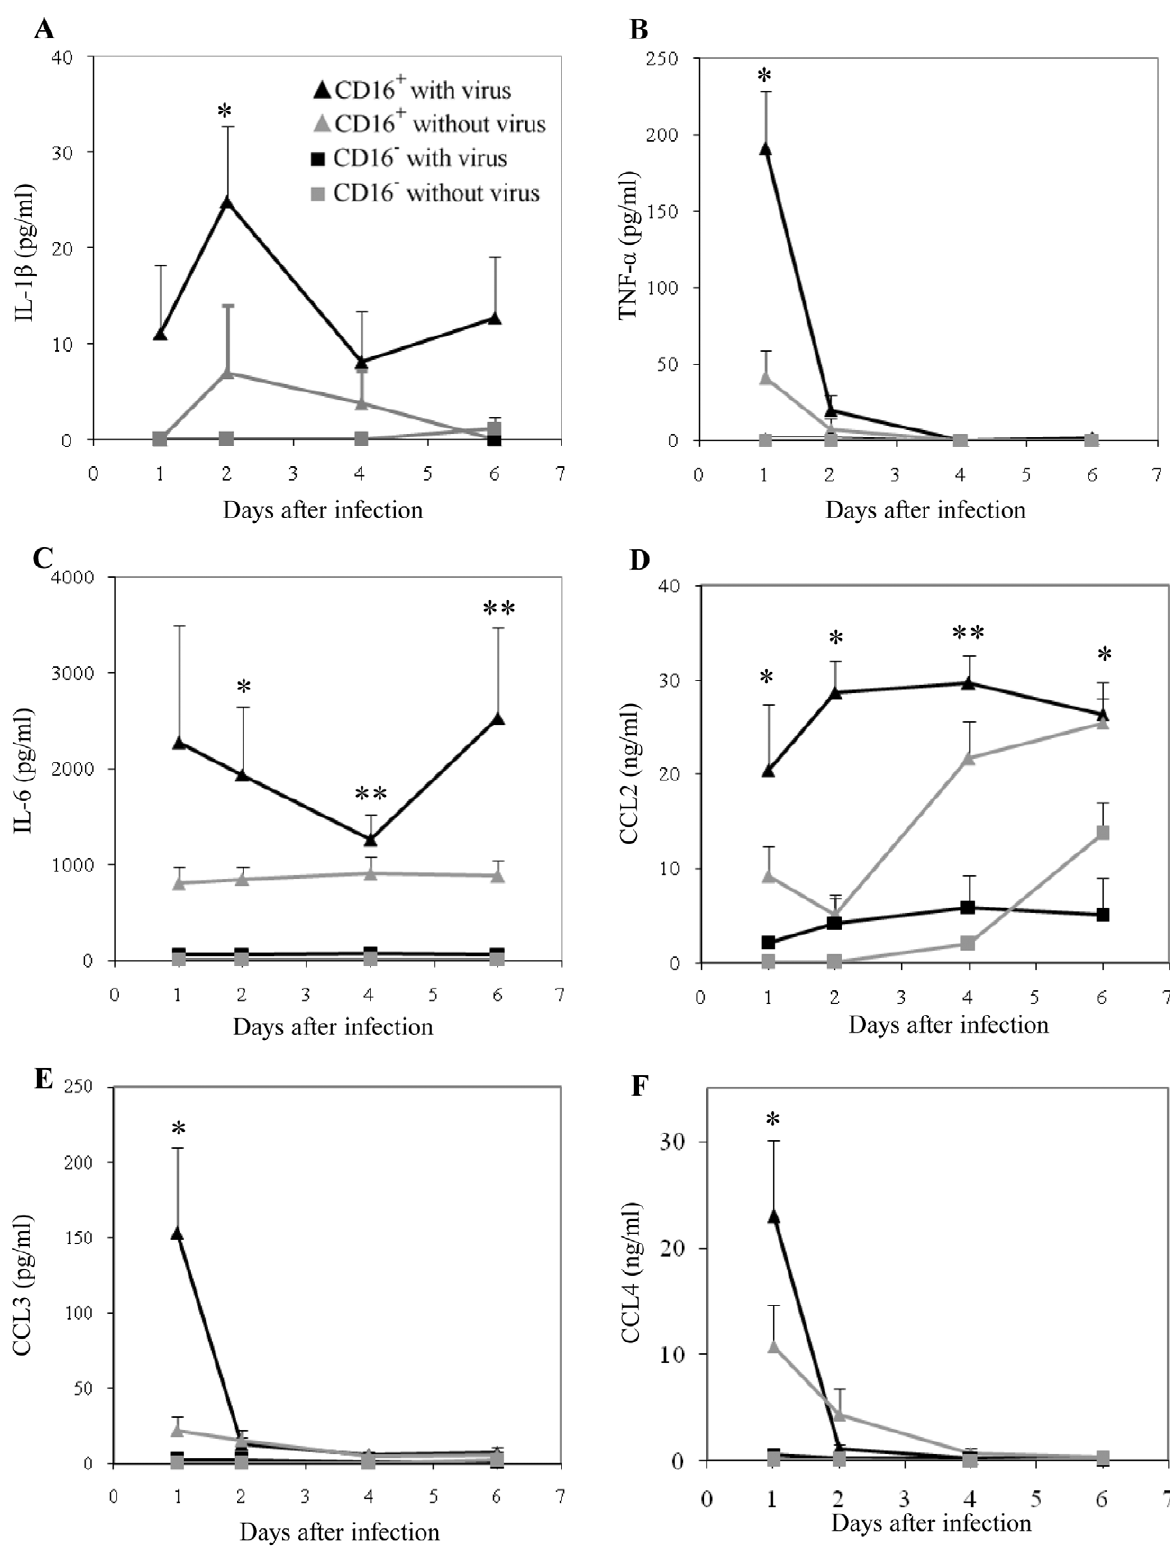
Figure 3. Production of inflammatory cytokines by monocyte subsets. Monocyte subsets were exposed to dengue virus or medium without virus. Supernatants were harvested over the course of 6 days. Levels of (A) IL-1 b (B) TNF- a (C) IL-6 (D) CCL2 (E) CCL3 and (F) CCL4 were measured using multiplex bead arrays. Results are mean 6 SE of 5 different donors. * p , 0.05, **, p , 0.005 between CD16 + and CD16 2 monocytes with virus.